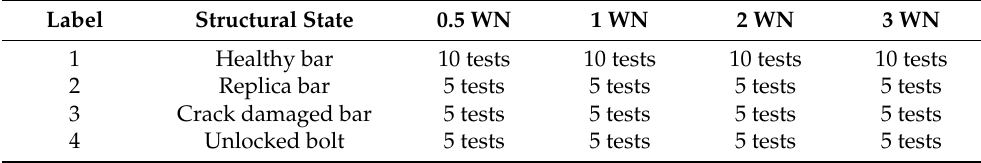
Table 1. Number of experiments for each structural state and white noise (WN) amplitude